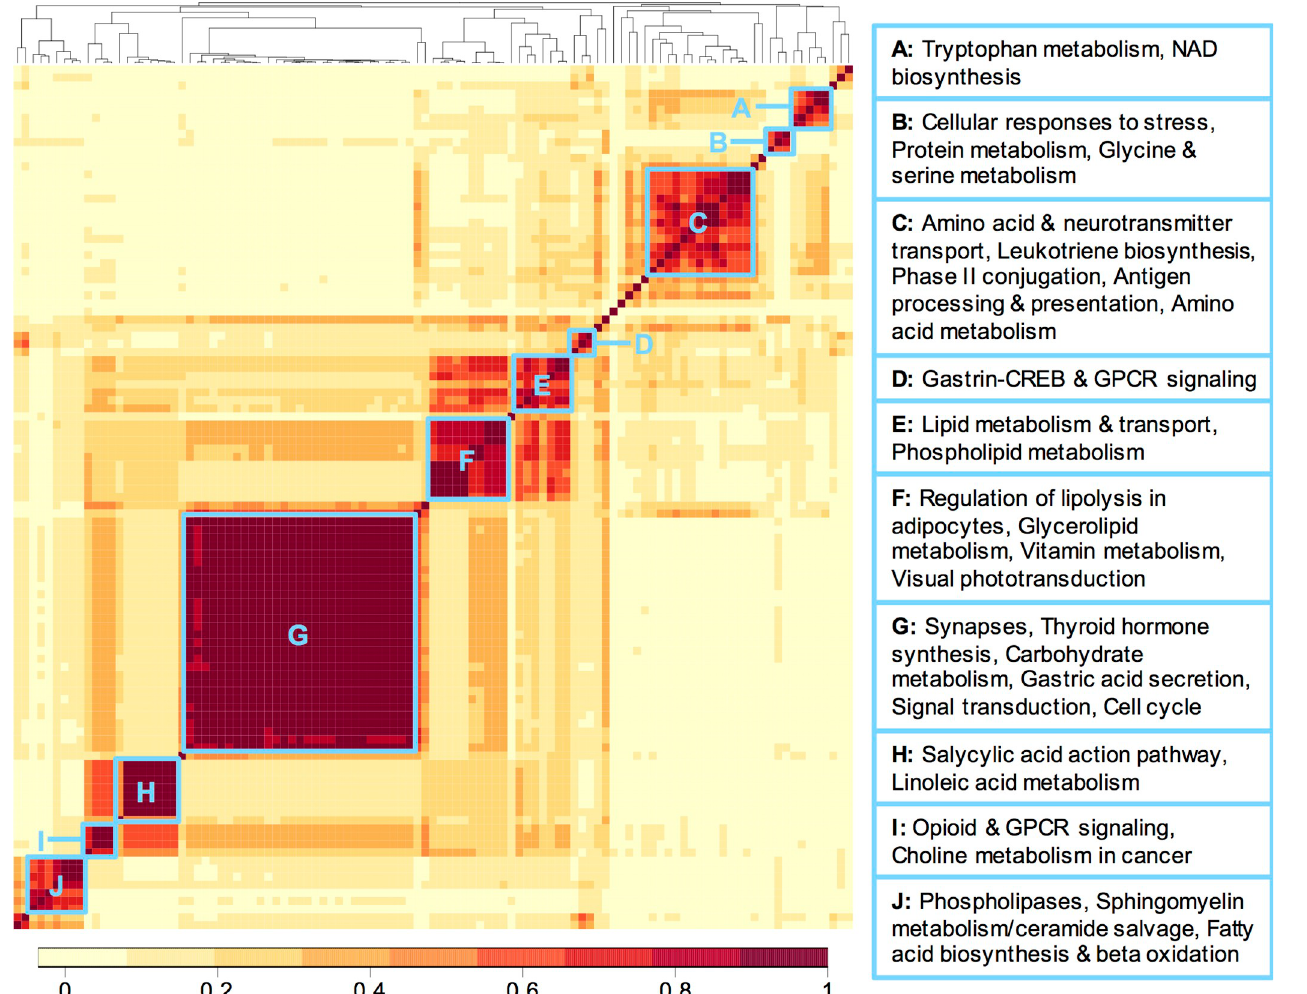
Fig 3. Clustered correlation heat map of 107 metabolite sets enriched (5% FDR) for both OE and MCDS BMI-associated signals. Correlation between metabolite sets were calculated using the BioAge annotation matrix. Color key indicates correlation values between each pair of metabolite sets. Distinct clusters (blue boxes with labels A-J) are highlighted, with representative pathway names in the clustered metabolite sets shown to the right of the heat map.